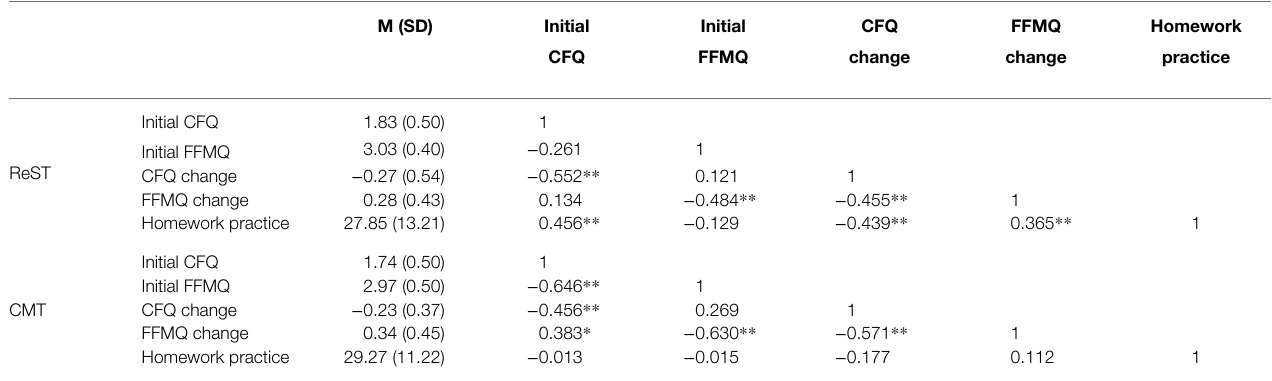
TABLE 1 | Means and standard deviations for all variables and bivariate correlations between them, separately for restoration skills training (ReST; n = 55) and conventional mindfulness training (CMT; n = 44) course completers. M